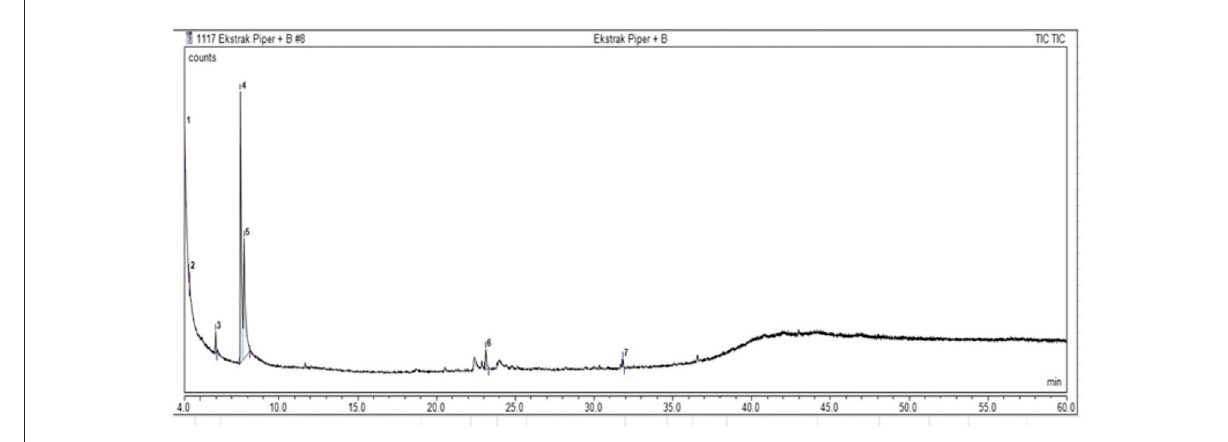
FIGURE7 GC-MS chromatogram fermentation of P. caninum extract with B. agri .